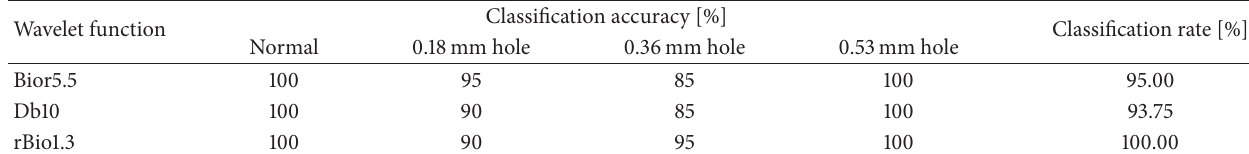
Table 5: The classification results under different wavelet functions.